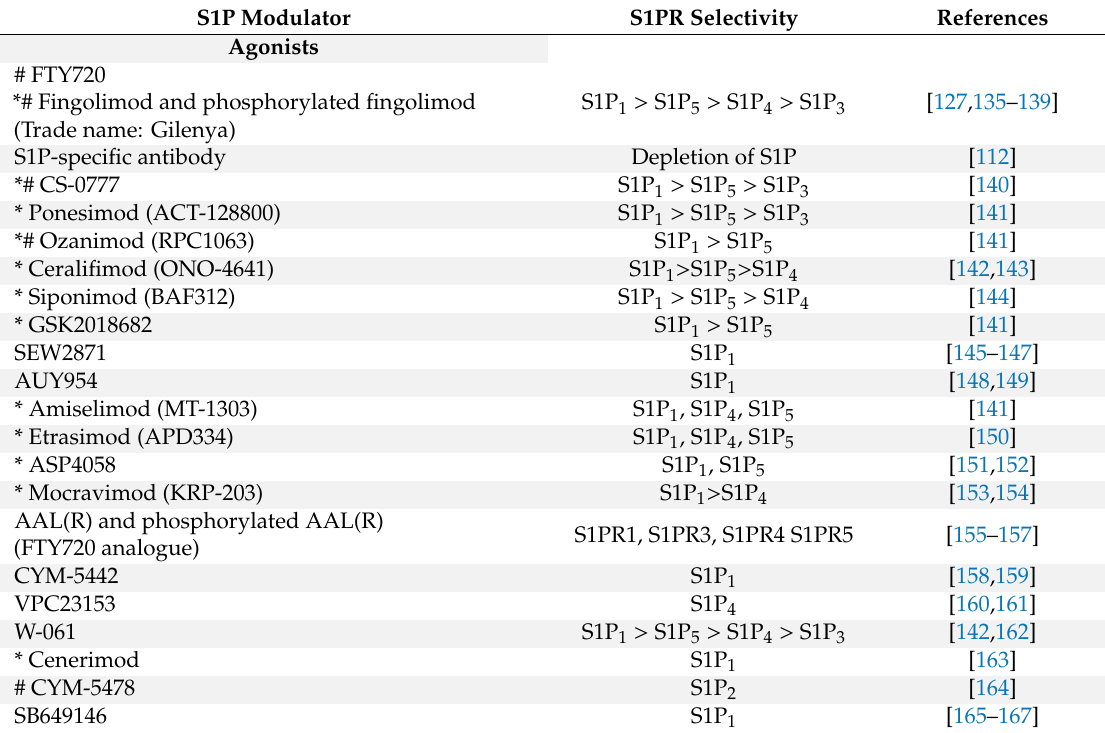
Table 1) and developed for clinical application in multiple complex diseases including autoimmune diseases, chronic inflammatory diseases, diabetes, and multiple organ failure [102,110,134]. Table 1. Comparative selectivity of the S1P